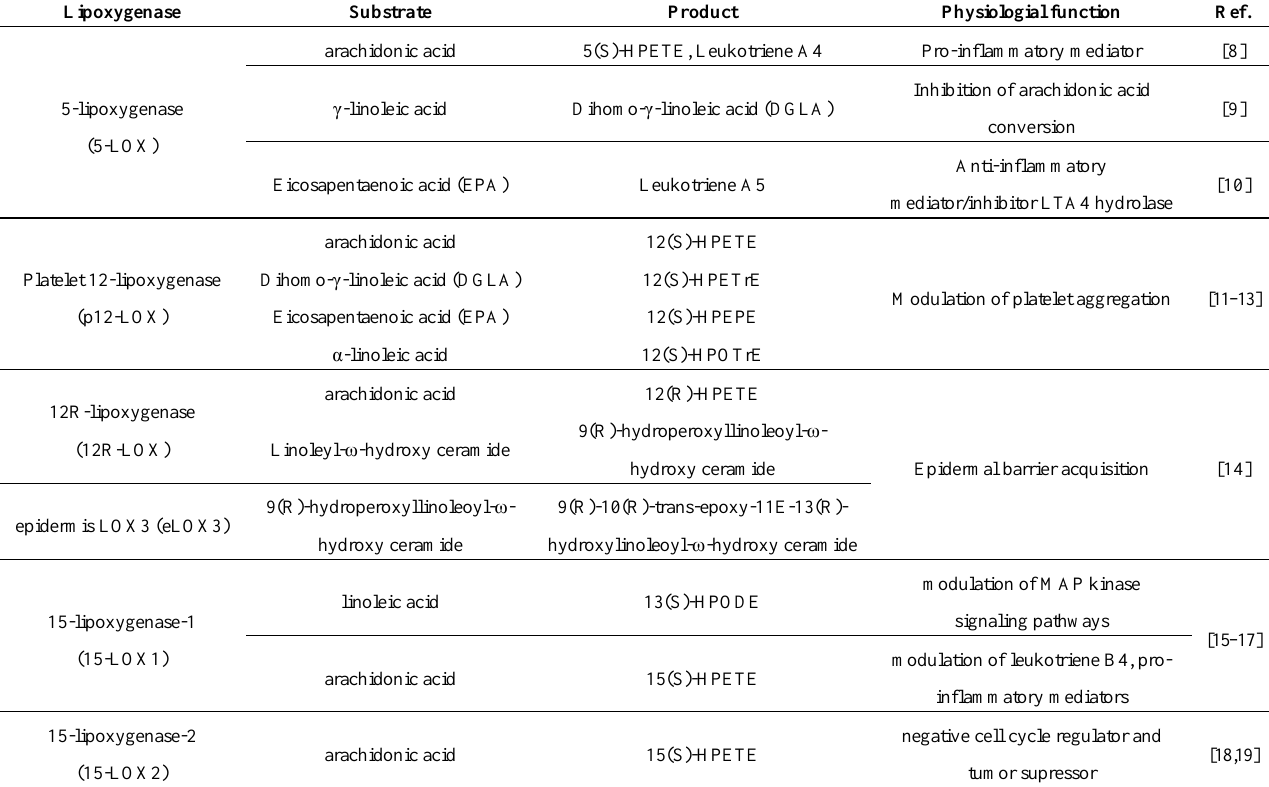
Table 1. Human lipoxygenases and their most important substrates, products, and